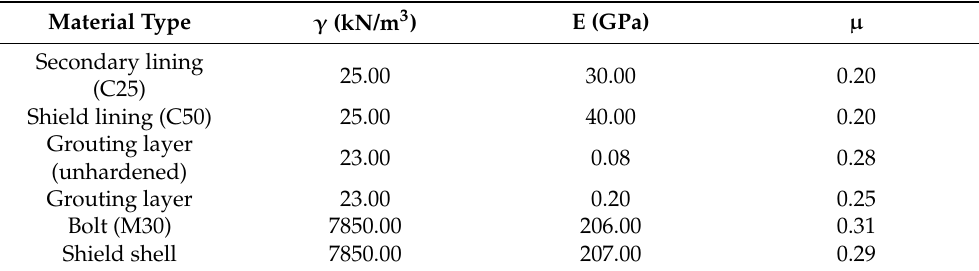
Table 3. Shield construction material parameters.